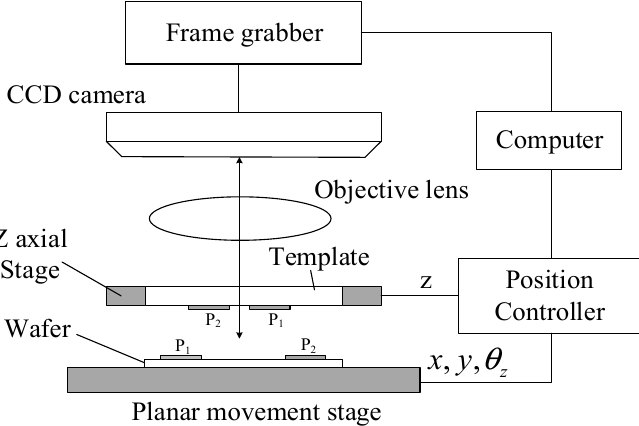
Figure 9. Schematic of the digital Moiré fringe alignment principle. This alignment scheme does not include the laser alignment light source. Only the grating image recorded by CCD generates multiplicative Moir é fringes through computer simulation. The phase analysis method of digital Moir é fringes is consistent with the Moir é fringes generated by the superposition of the aforementioned physical gratings. The two- dimensional FFT and the phase unwrapping algorithm were used to measure the angular displacement. When the two planes are parallel, the relative displacement is measured by extracting and analyzing the phase difference in the frequency domain, and in-plane displacement correction is realized. The alignment accuracy is better than 10 nm [43]. Computers were used to capture grating images to generate Moir é fringes, which can flexibly adjust the mode of superposition and filtering; Moir é fringes generated under various conditions can easily improve accuracy. Moreover, the Moir é fringes generated by computers are less affected by the environment, and phase extraction is easy. alignment, but the Moir é fringes were still produced by superimposed natural light